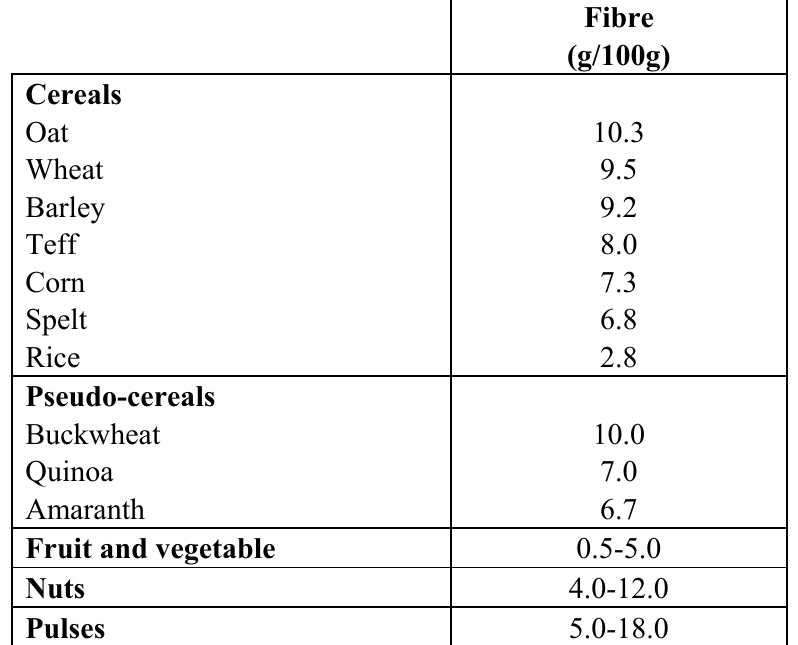
Table 6. Fibre content in different plant